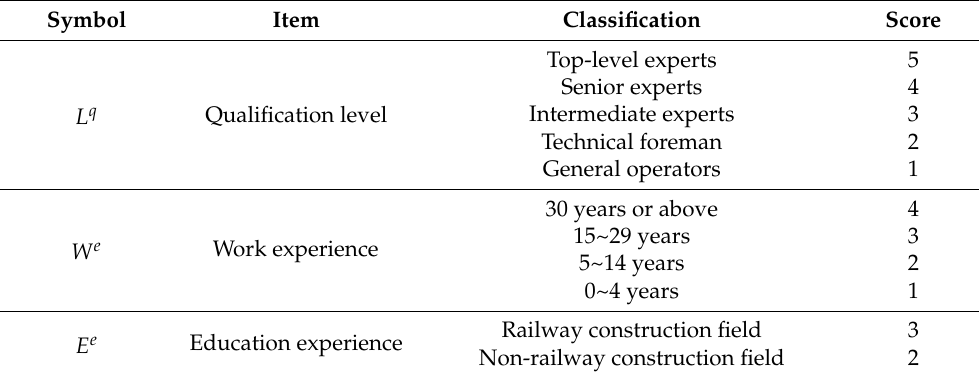
Table 5. Demographics of the